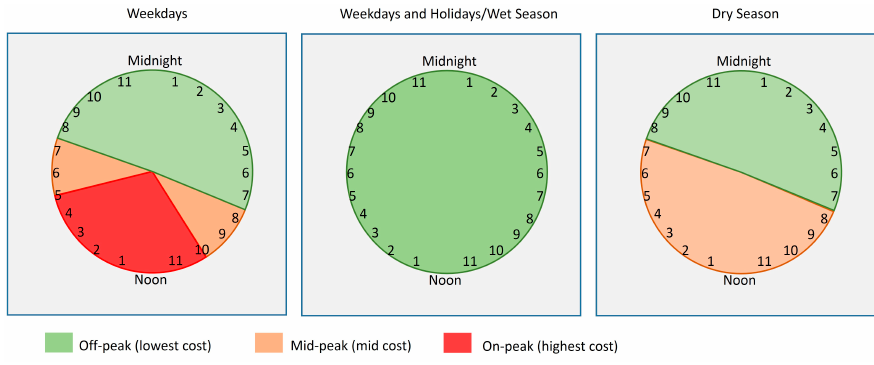
Figure 3. Overview of water pricing design and structures: ( a ) All customers pay the same price regardless of the amount they consume; ( b ) the total price of water is dependent on the amount of water a customer uses. The unit price of water does not change but the total monthly price will change. ( c ) Customers are charged for water based on increasing (or decreasing) flat rates; i.e., the price of water changes once a limit has been reached. ( d ) Water price changes once a certain limit has been reached and constantly increases. The total water price will always be different depending on water consumption. ( e ) Water pricing is adjusted based on the time of day. The unit price of water is higher during peak hours to encourage water conservation; water pricing is adjusted based on climatic conditions, for example, wet and dry season.